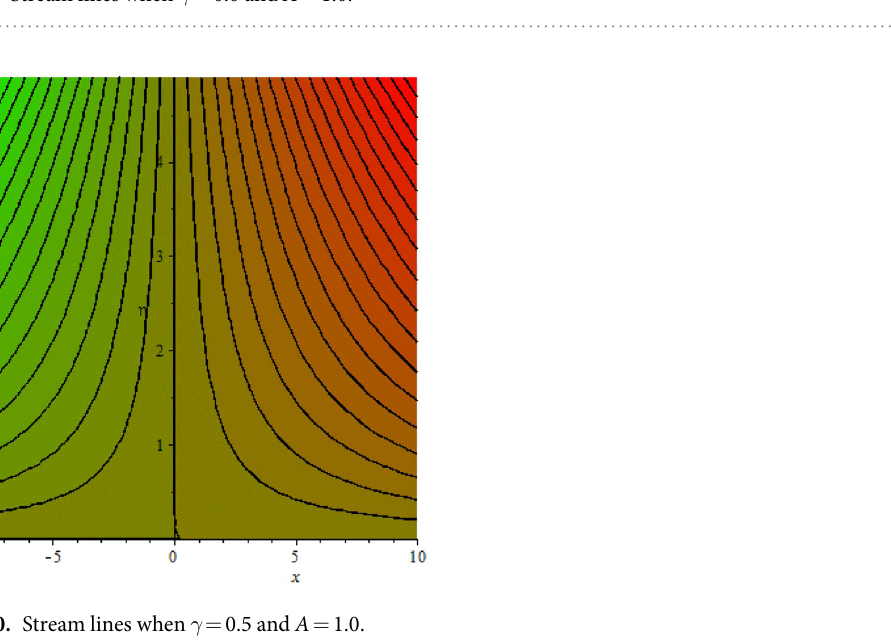
Figure 10. Stream lines when γ = 0.5 and A =